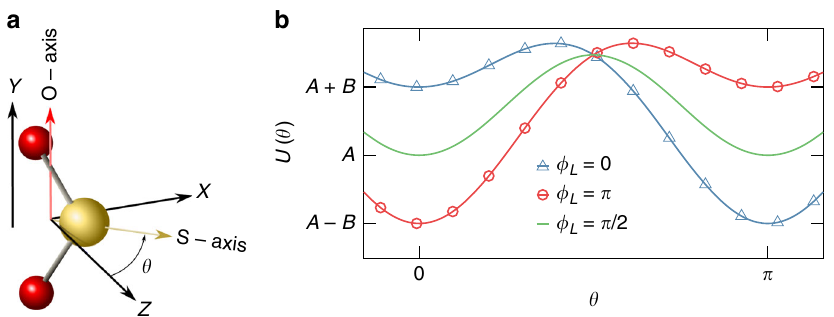
Fig. 2 One-dimensional model geometry. a SO 2 molecule, the atoms are color coded: sulfur — yellow, oxygen — red. The major axis is perfectly aligned along the laboratory Y axis. The minor axis lies in the XZ plane at an angle θ relative to the Z axis. b Potential energy as a function of θ for ϕ L = 0, π , π /2 (see Eqs. 3